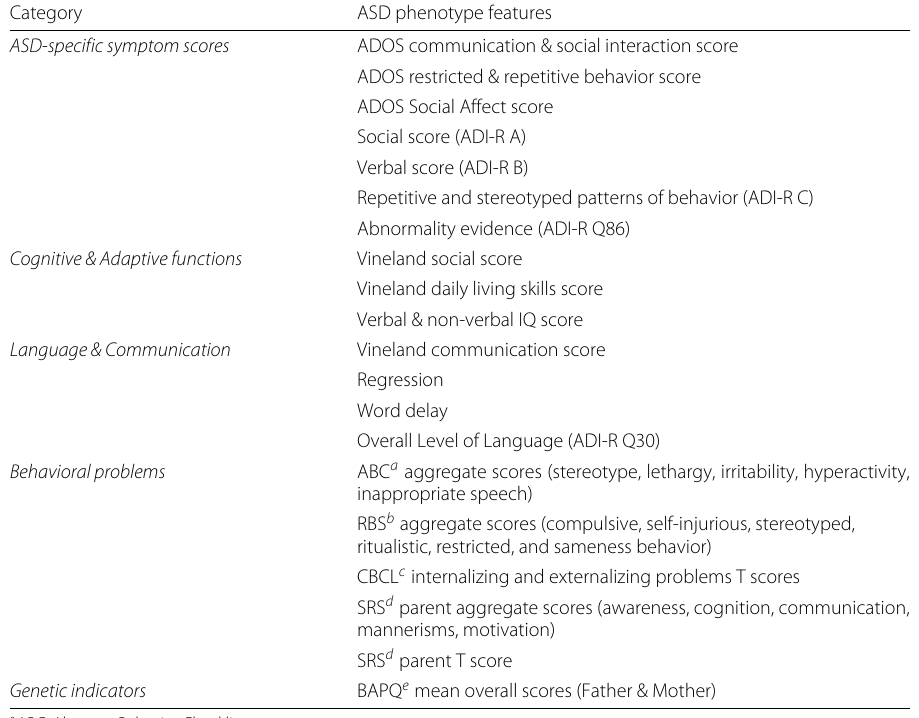
Table 2 Description of 36 phenotype features used to cluster ASD